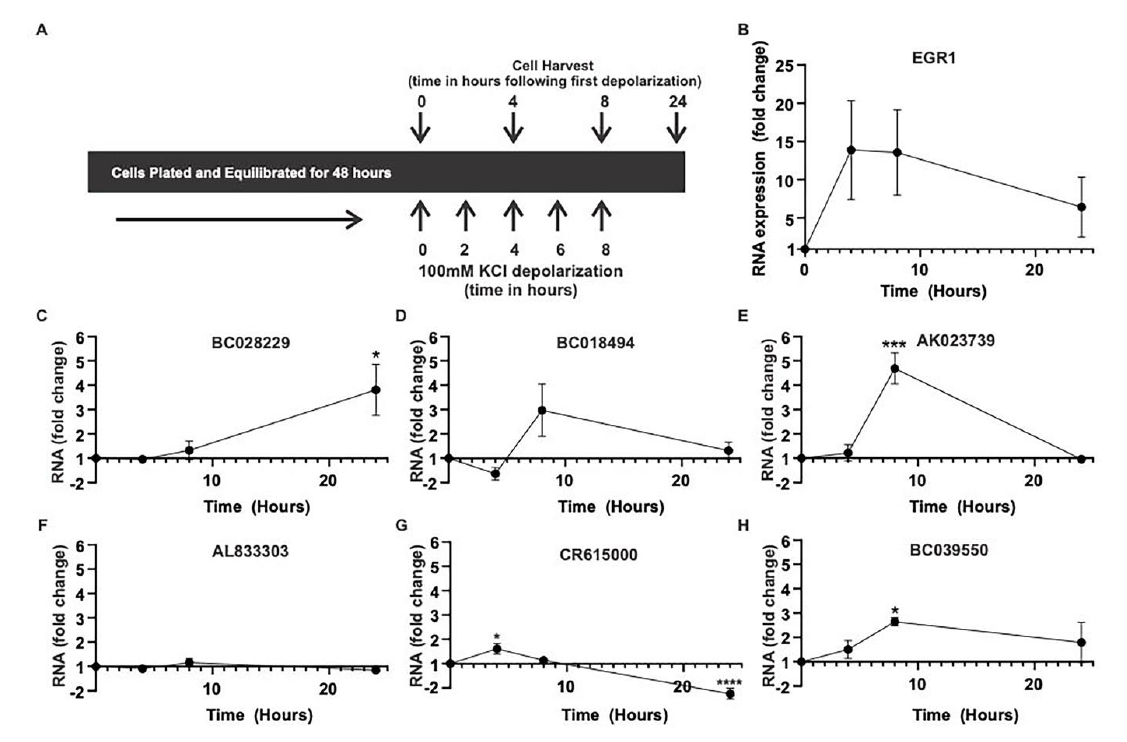
Figure 3. Variability in activity-dependent lncRNA induction. ( A ) Repeated KCl-induced depolariza- tions were used to model activity-dependent signaling in vitro. qPCR was performed to measure RNA expression at the specified time points. All results are displayed as fold change in comparison to time-matched controls. ( B ) EGR1 increases with activity at four- and eight-hours following depolarization. ( C ) BC028229 shows a steady increase in activity-dependent expression reaching three-fold by 24 hours (* p < 0.05, two-way ANOVA, n = 3, DF = 6), ( D ) BC018494 increases expression by three-fold at eight hours ( p = 0.12, two-way ANOVA, n = 3, DF = 6), ( E ) AK023739 increases 4.5-fold at eight hours (*** p = <0.001, two-way ANOVA, n = 3, DF = 6), ( F ) AL83303 does not change, ( G ) CR61500 has a two-fold increase at four hours (* p < 0.05, **** p < 0.0001, two-way ANOVA, n = 3, DF = 6), and ( H ) BC039550 has a three-fold increase at eight hours (* p < 0.05, two-way